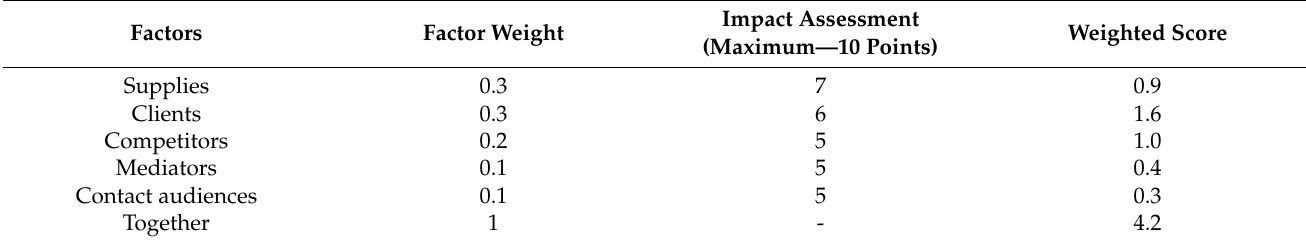
Table 2. Analysis of the influence of microenvironment factors on the activities of PJSC “NOVATEK”.